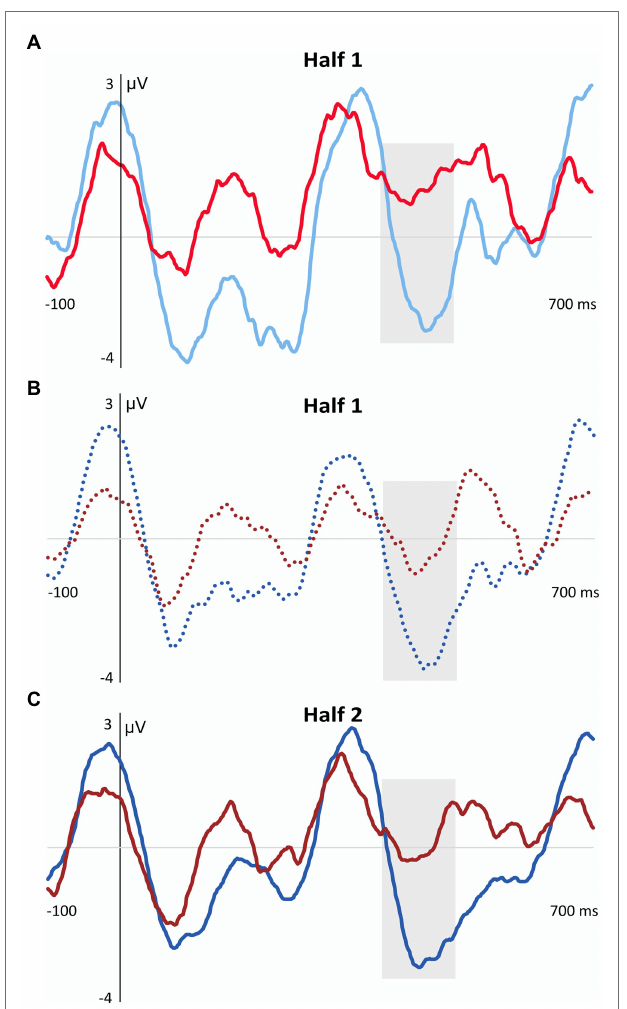
FIGURE 5 | Graphical representation of the Group Effect Observed in the N400 Component for the Implicit and Explicit aSL Tasks as a Function of Type of “Word” and Length of Exposure. Gray shadowed rectangles indicate the N400 time window. (A) Group effect in the first half of the implicit aSL task in the high-TP condition. Light red solid line = Development language disorder group; Light blue solid line = Typical language development group. (B) Group effect in the first half of the explicit aSL task in the low-TP condition. Dark red dotted line = Development language disorder group; Dark blue dotted line = Typical language development group. (C) Group effect in the second half of the aSL explicit task in the high-TP condition. Dark red solid line = Development language disorder group; Dark blue solid line = Typical language development group.